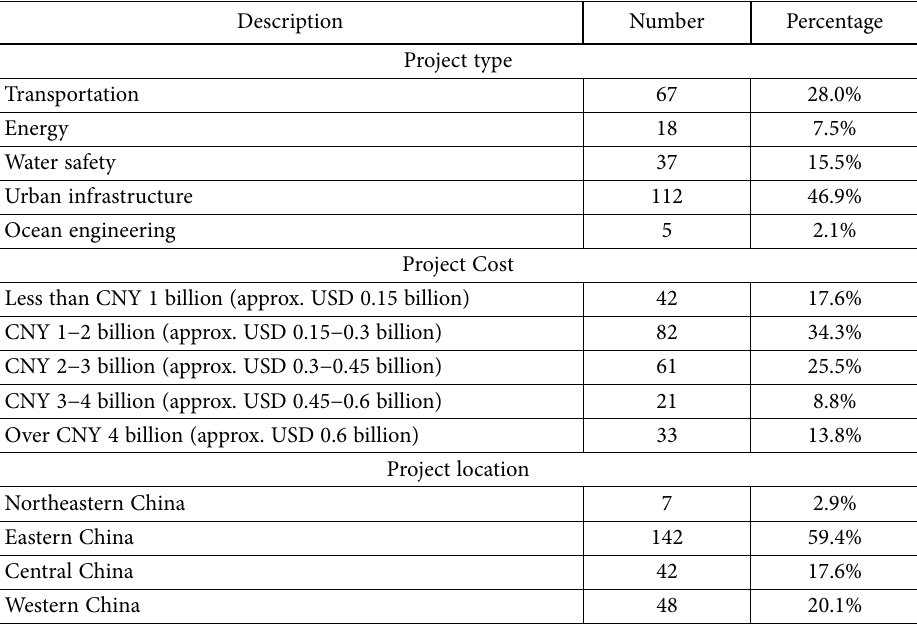
Table 5. Profile of megaprojects participated by questionnaire